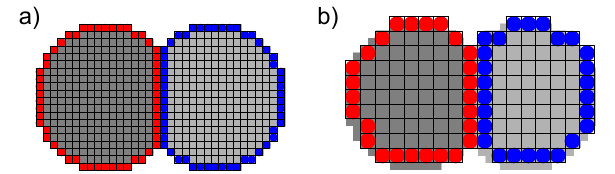
Figure 6. Example of the discrete element representation of two grains but with different effective resolutions (diameters of